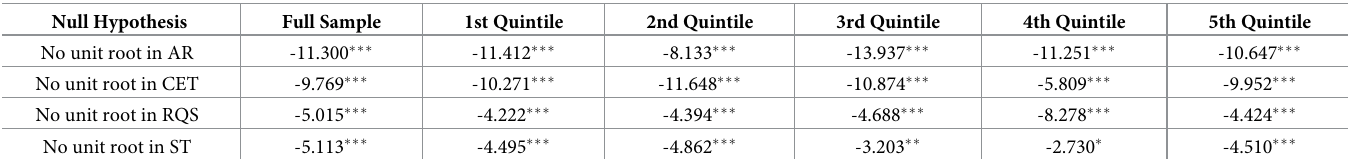
Table 3. ADF unit root results of the liquidity measures for the full sample and quintile